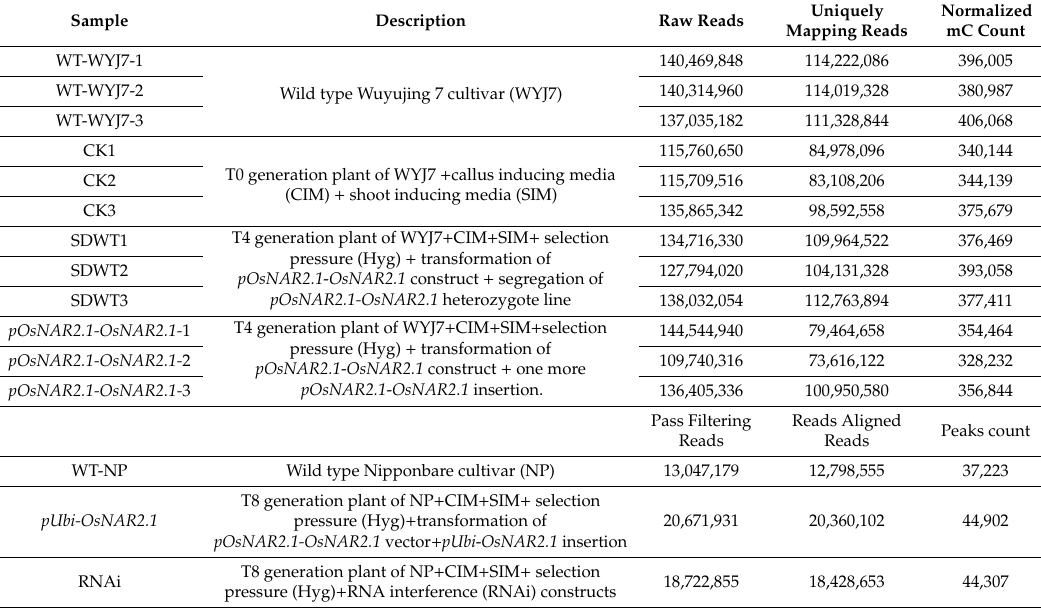
Table 1. Samples description in this